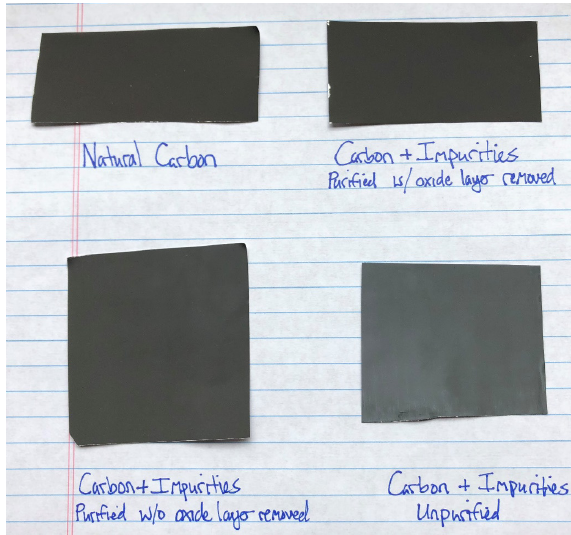
Fig. 4. Foils produced from each carbon sample.